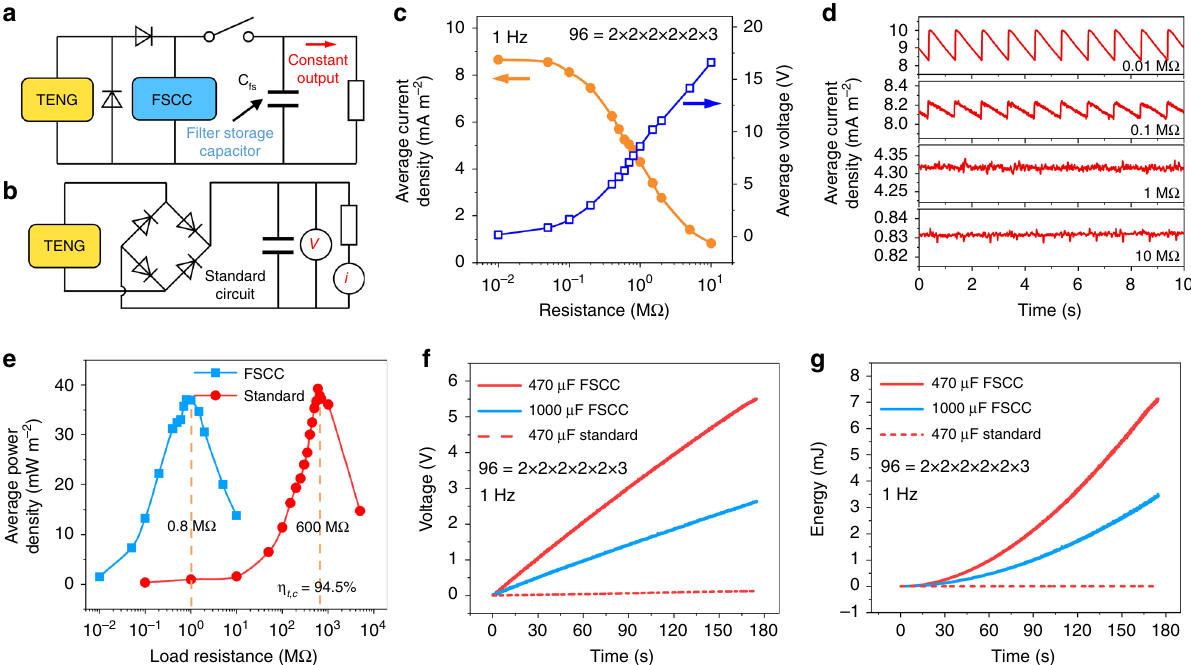
Fig. 4 Maximizing constant output with FSCC power management system. a The 96 = 2 × 2 × 2 × 2 × 2 × 3 FSCC power management system with constant output. The fi lter storage capacitor is 470 μ F. b The standard circuit with the constant output for TENG. The fi lter storage capacitor is 1 μ F. c The average current density and voltage at different loads with FSCC power management. d The current waveform at different loads with FSCC power management. e The average power density of FSCC power management and the standard circuit. The total energy transfer ef fi ciency of 94.5% is achieved. f Charging capacitors and g Corresponding cumulative